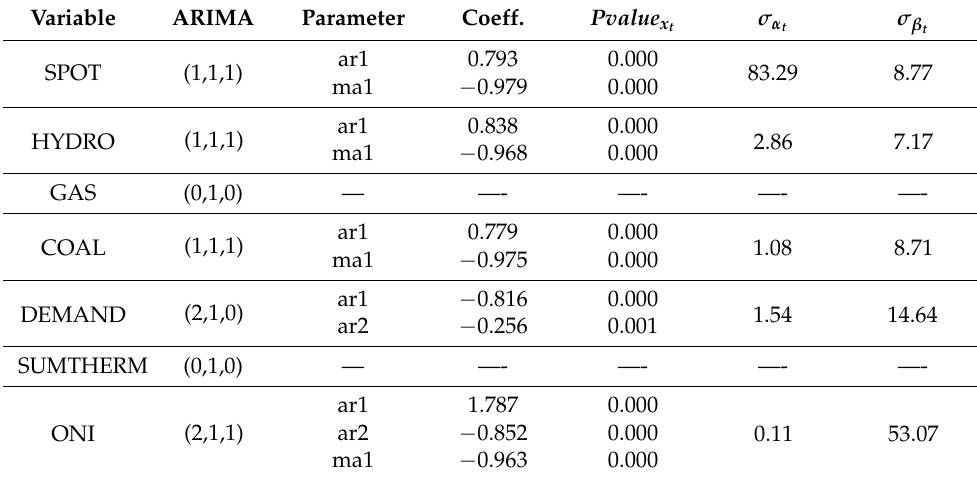
Table 4. Results of the prewhitened series ( α t and β t